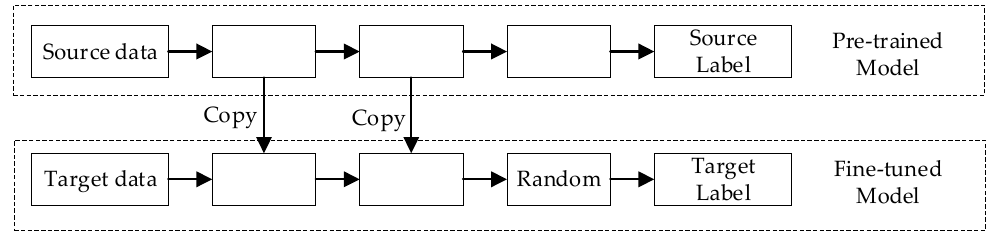
Figure 3. Process of fine-tuning a deep learning network.